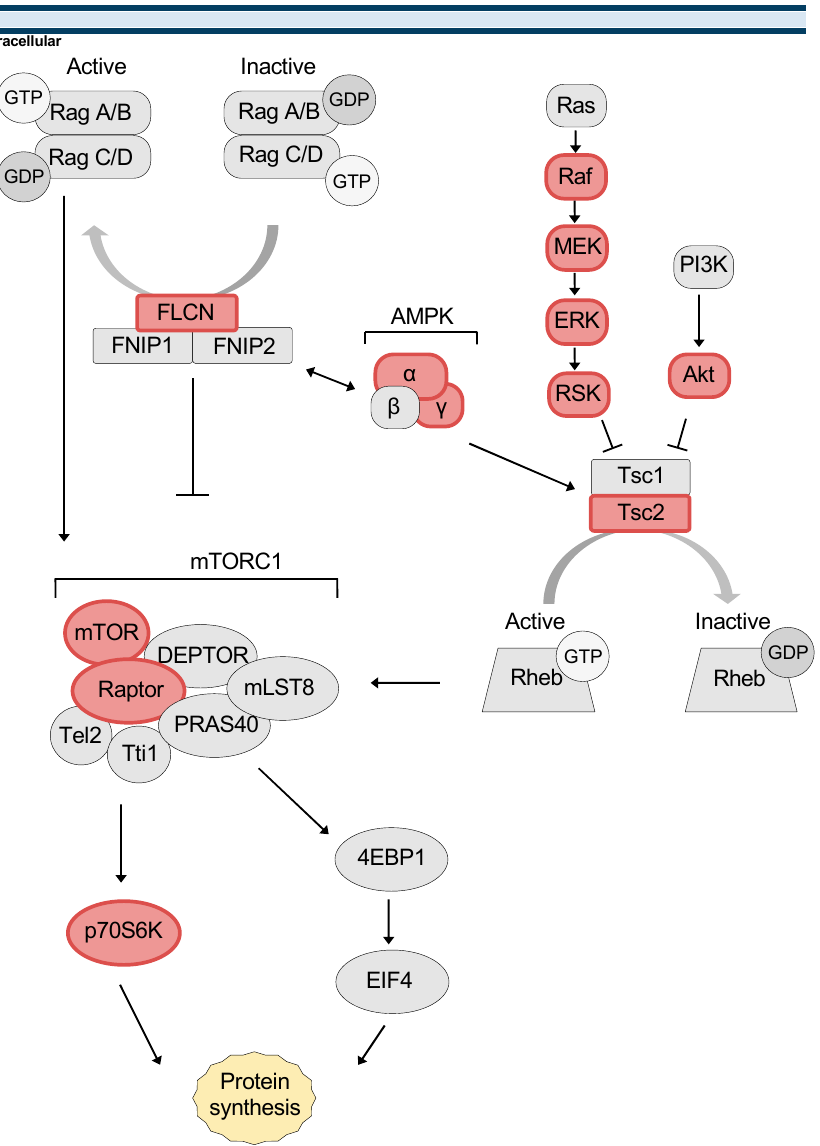
Figure 5 . Hsp90 clients in the mTOR pathway. A schematic representation of the mTOR pathway highlighting the components that are Hsp90 clients (red).